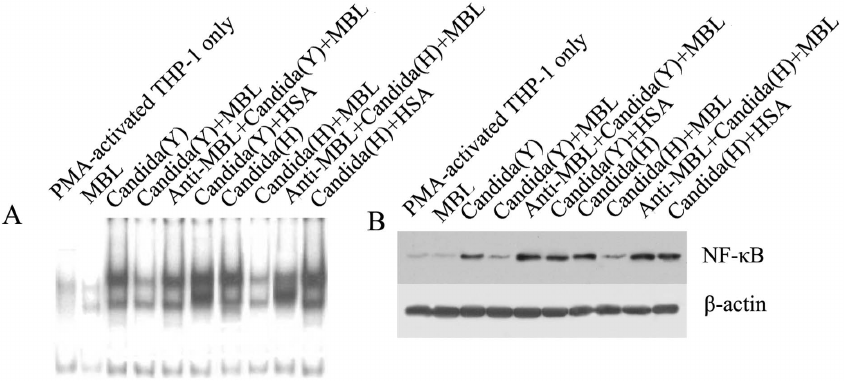
Figure 5. MBL decreases C.albicans -stimulated NF- k B binding activity and translocation in PMA-activated THP-1 cells. (A) MBL inhibits C. albicans -stimulated NF- k B DNA-binding activity. PMA-activated THP-1 cells (5 6 10 5 cells/sample) were stimulated with heat-inactivated Y or H cells of C. albicans at a Candida/THP-1 ratio of 2:1 in the presence of the indicated concentrations of MBL, anti-MBL pAb and MBL, or HSA for 1 h, then harvested to prepare nuclear extracts. The nuclear extracts were mixed with radiolabeled NF- k B oligonucleotide probe and analyzed with EMSA. (B) NF- k B translocation is inhibited by MBL in PMA-activated THP-1 cell. PMA-activated THP-1 cells (5 6 10 5 cells/sample) were stimulated with HK Y or H cells of C. albicans at a Candida/THP-1 ratio of 2:1 in the presence of 20 m g/ml MBL, anti-MBL pAb and MBL, or HSA for 1 h, then the cells were harvested to prepare nuclear extracts. The proteins in the nuclei-free supernatants were separated by 10% SDS-PAGE, followed by transfer to a nitrocellulose membrane. After blocking, the membrane was incubated with the NF- k B-specific mouse anti-human mAb p65, followed by HRP- conjugated secondary antibody. ECL was used to visualize the protein bands. b -actin was used as an internal control.